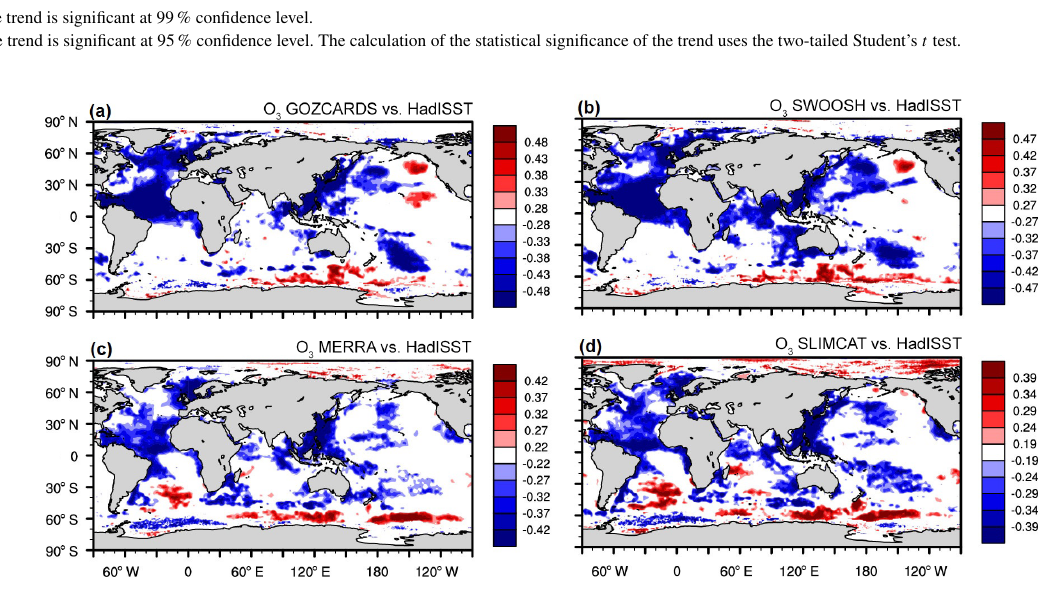
Figure 13. As Fig. 2 but with only the seasonal cycle removed before calculating the correlation coefficients.